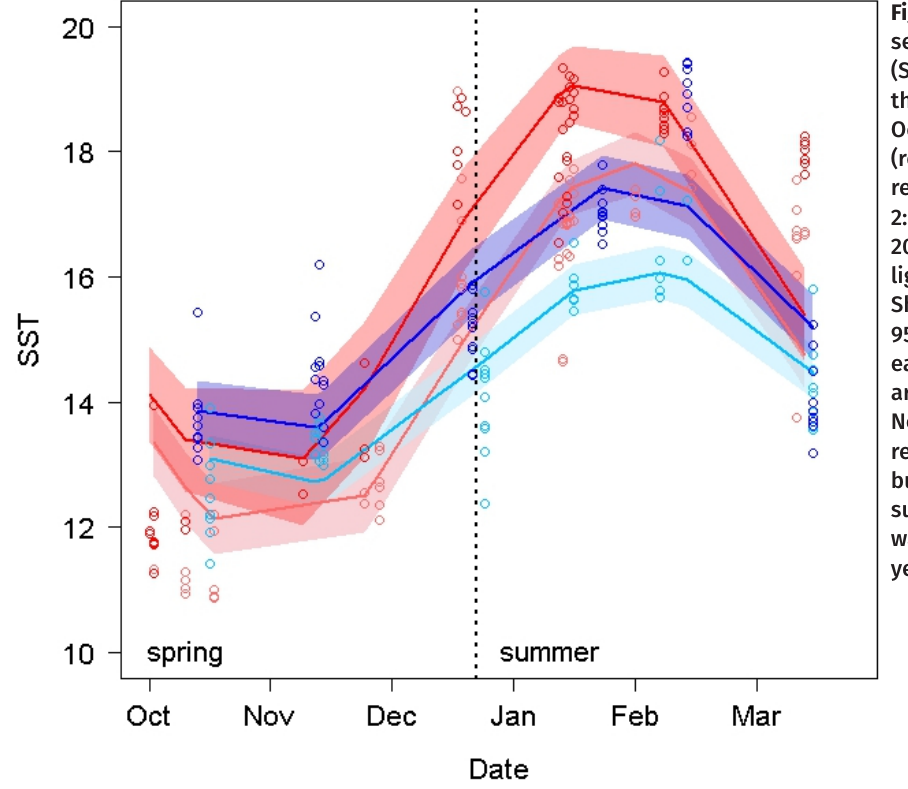
light-blue: West domain). Shaded areas represent 95% confidence regions for each fitted curve. Raw data are showed as open circles. Note that the confidence regions overlap in spring, but they separate during summer. Thermal amplitude was greater during the first year